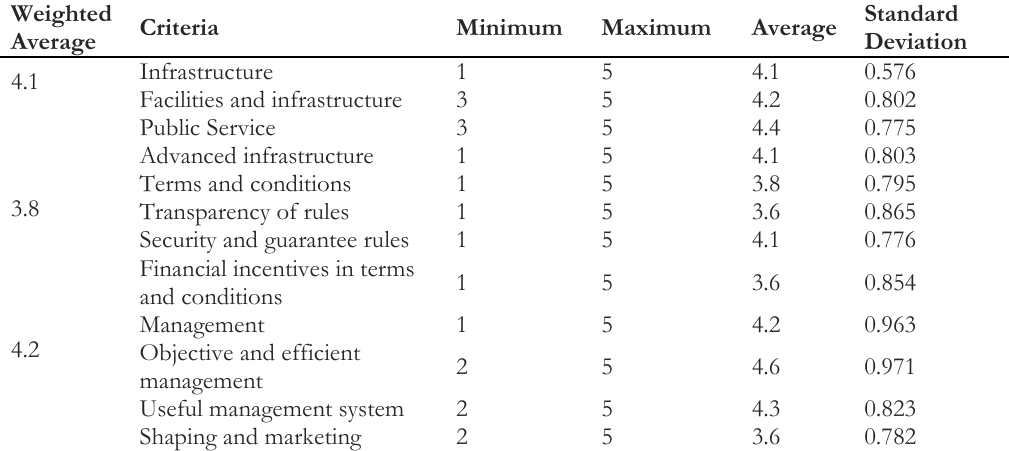
Table 2. The weight of each criterion and the range of